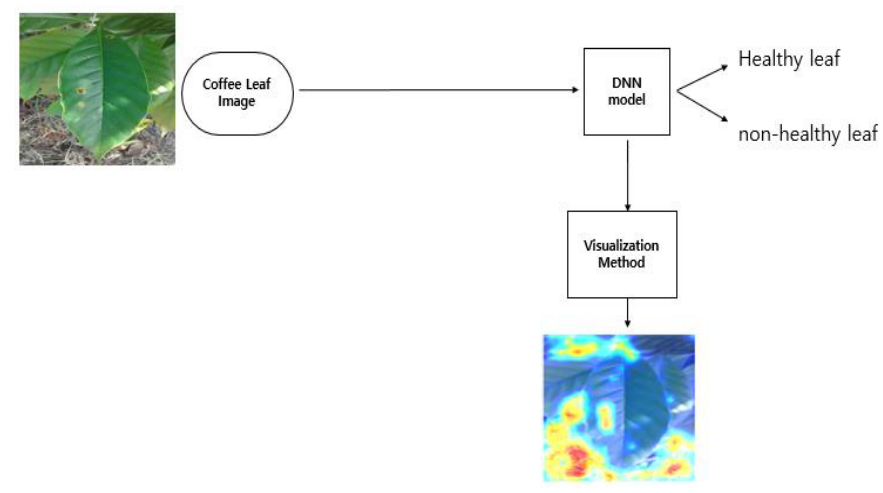
Figure 5. The pipeline of the naïve approach.